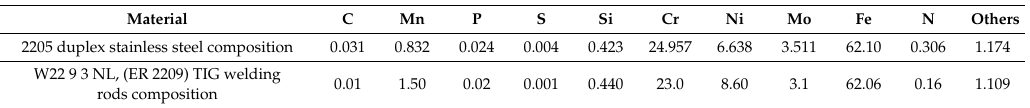
Table 1. Chemical composition (spectral analysis) of Duplex 2205 stainless steel plates and